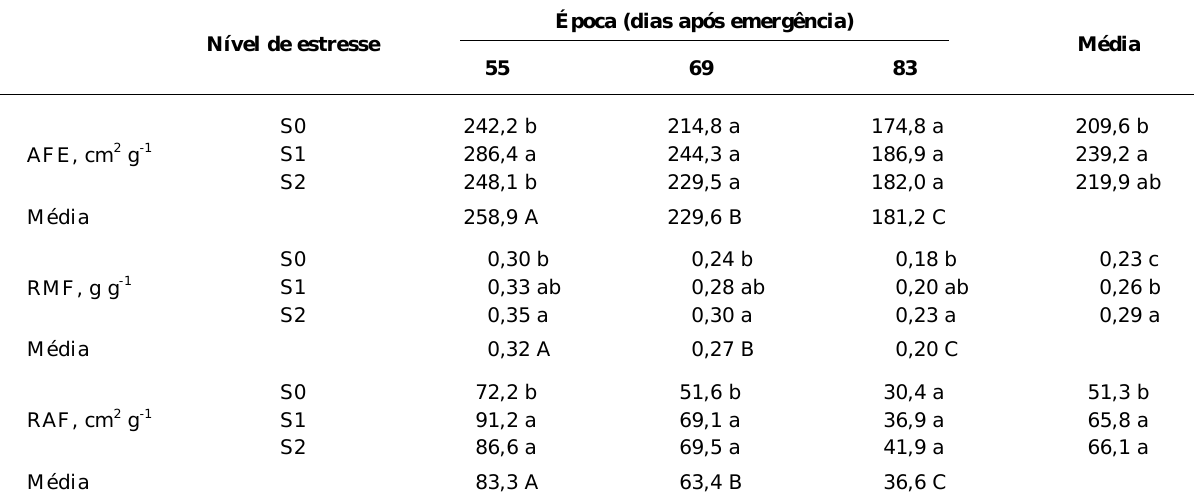
Quadro 6. Valores médios de área foliar específica (AFE), razão de massa foliar (RMF) e razão de